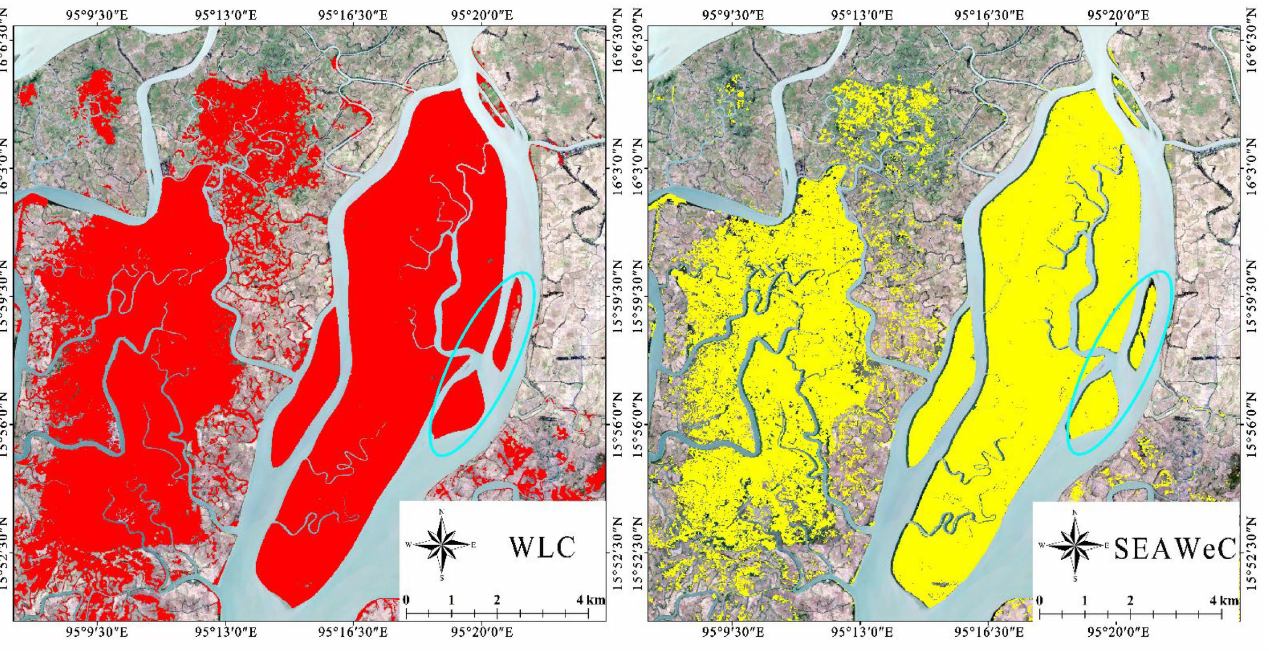
Figure 15. A comparison of the SEAWeC from the WLC